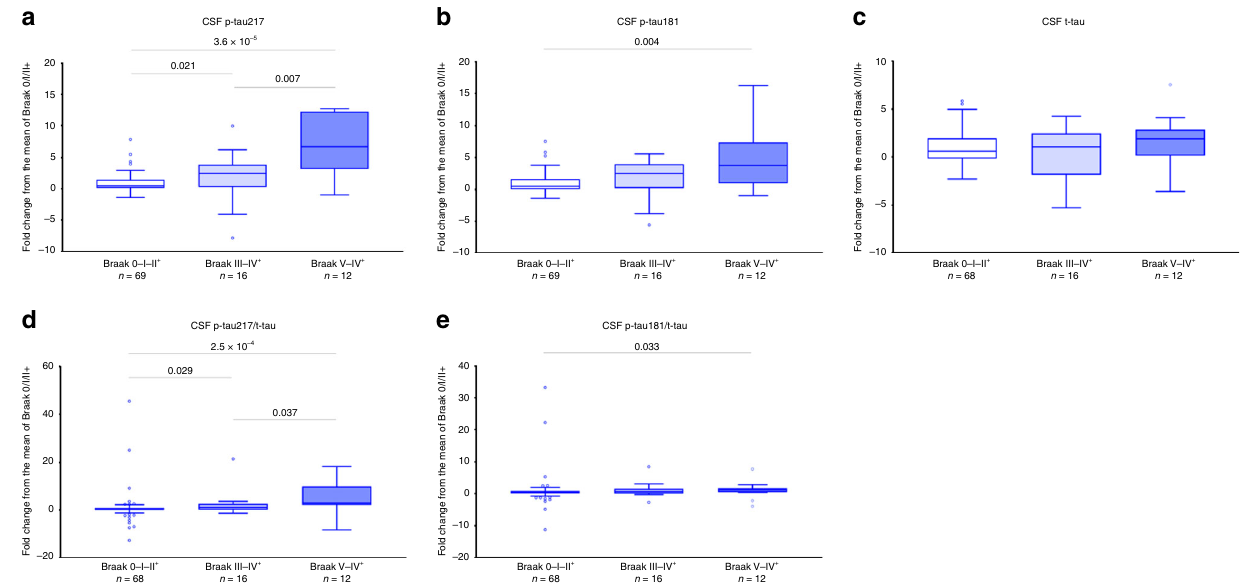
Fig. 3 Longitudinal changes in CSF p-tau across the Braak ROI groups. Study participants were staged into different Braak ROI groups using [ 18 F] fl ortaucipir PET. [ 18 F] fl ortaucipir data was dichotomized based on the SUVR cutoff of 1.3 26 . Annual changes in CSF p-tau217 ( a ), p-tau181 ( b ), t-tau ( c ), p-tau217/t-tau ( d ), and p-tau181/t-tau ( e ) in the Braak 0-I – II (normal [ 18 F] fl ortaucipir retention or abnormal [ 18 F] fl ortaucipir retention limited to ROI I – II, n = 69), III – IV (abnormal [ 18 F] fl ortaucipir retention in ROIs III – IV, n = 16) and V – VI (abnormal [ 18 F] fl ortaucipir retention in ROI V – VI, n = 12) groups. P values (unadjusted for multiple comparisons) are from Mann – Whitney test; boxes show interquartile range, the horizontal lines are medians and the whiskers were plotted using Tukey